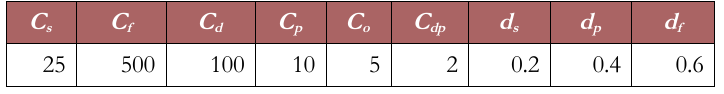
Table 1. The parameters of cost and